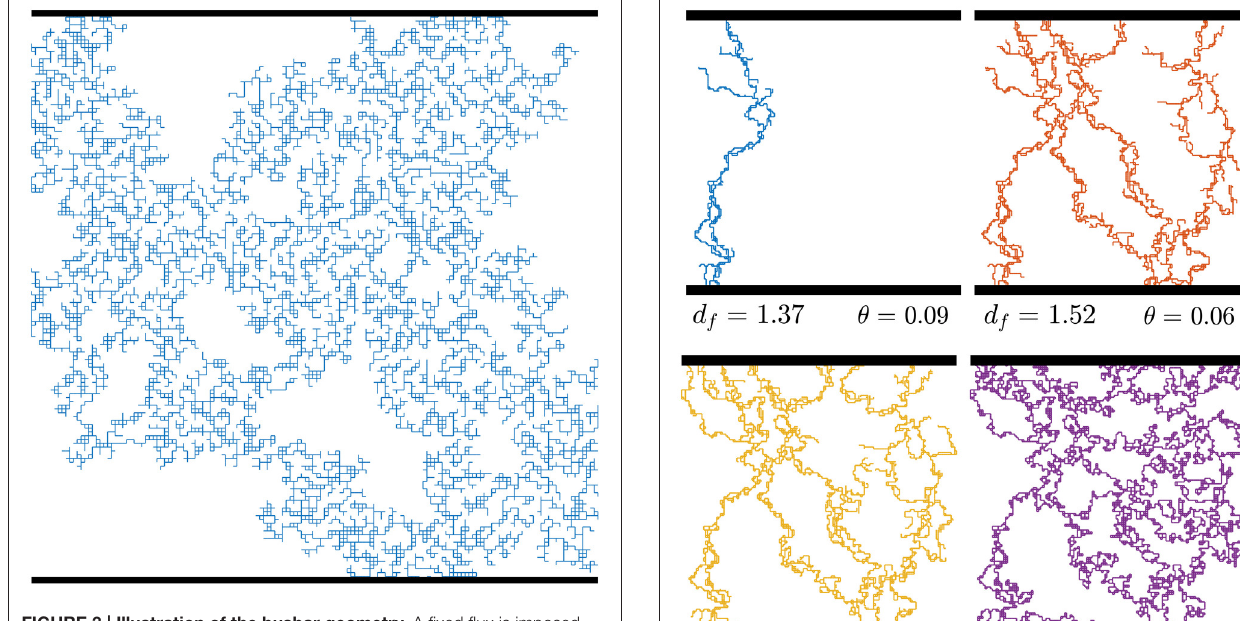
FIGURE 3 | Illustration of the busbar geometry. A fixed flux is imposed between the two edges (represented by the black thick lines).